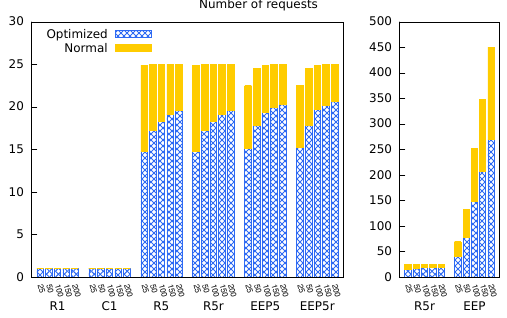
Figure 9: Number of requests to the RPS.